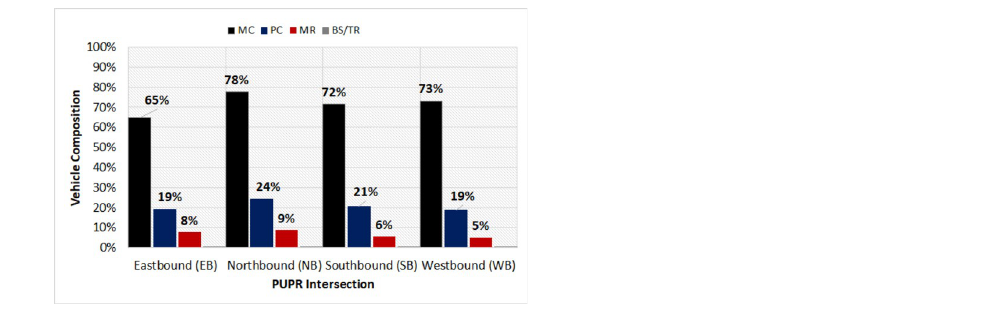
the composition of vehicles through this mixed traffic was often diverse, consisting of light and heavy cars, motorcycles, rickshaws, etc. Each vehicle type was also found to have different effects on traffic, as a vehicular conversion factor was needed. The unit of this factor is known as passenger car unit (PCU). Additionally, the PCE value was considered as the critical part of capacity estimation. This was due to the capacity being often expressed as PCU/h, while the PCU was only determined through the PCEs [10]. Table 1 indicated that the log marginal likelihood and DIC among the two proposed models were not significantly different. This was due to the first (2,628.39) and second (2,628.49) mod- els of the DIC substantially having similar values. However, the contrast in DIC among com- pared models that were less than 5, was considered to be insignificantly different [22]. The PCEs of each vehicle types were calculated through the ratio of their headways to the PC. According to the average headway, the result of the PCEs calculated were listed in Table 1. This illustration statistically indicated that headway parameters were assigned with significant estimated coefficients, as they showed greater T-Statistic value at 1% error level. Based on Table 1, the headway corresponding to BS/TR was excluded due to insignificant variables belonging to heavy vehicles, especially at the PUPR and MAN Jambo Tape locations. This was partially due to the low volumes of heavy trucks and buses, during peak hour observation at these locations. Therefore, the PCEs are listed in Table 2 below. Based on the average headway